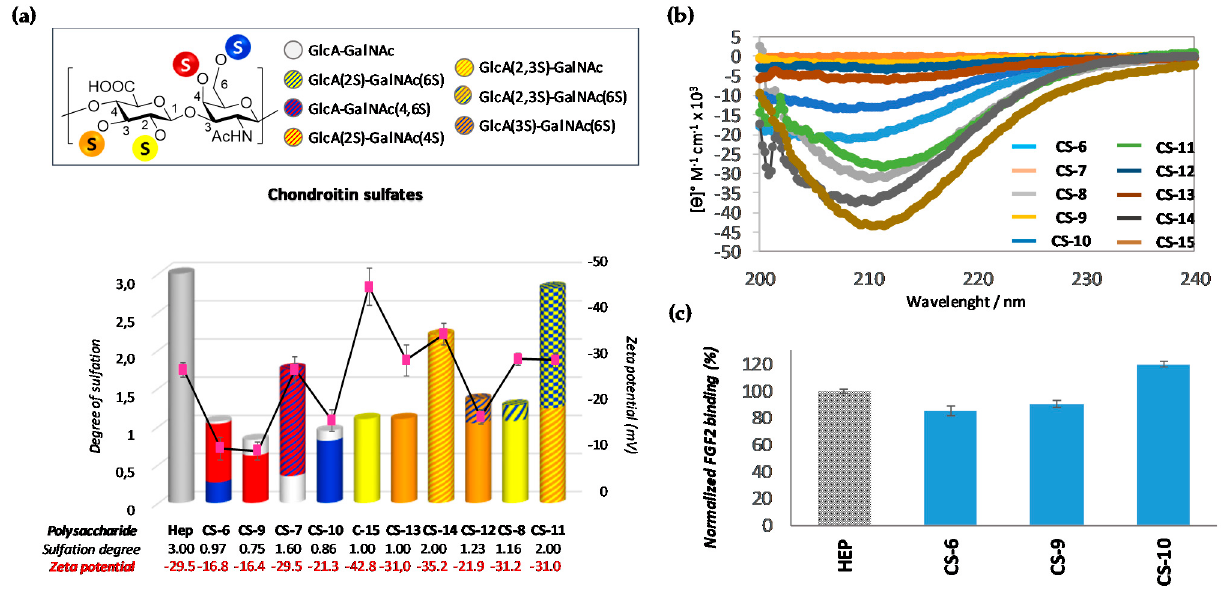
Figure 8. ( a ) Degree of sulfation of polysaccharides (their numerical values are indicated at the bottom, in grey). The pink points indicate the zeta-potential values (their numerical values are indicated at the bottom, in red). Sulfated-disaccharide composition of each polysaccharide is shown in colors (for interpretation, see figure legend). ( b ) CD spectra of polysaccharides. ( c ) SPR binding of immobilized FGF-2 to GalNAc sulfated derivatives (CS-6, CS-9 and CS-10) (0.5 mg/mL) normalized against heparin. All bar graphs are based on triplicate experiments. Table 4. Thermodynamic data of semi-synthetic CSs-FGF-2 interactions.